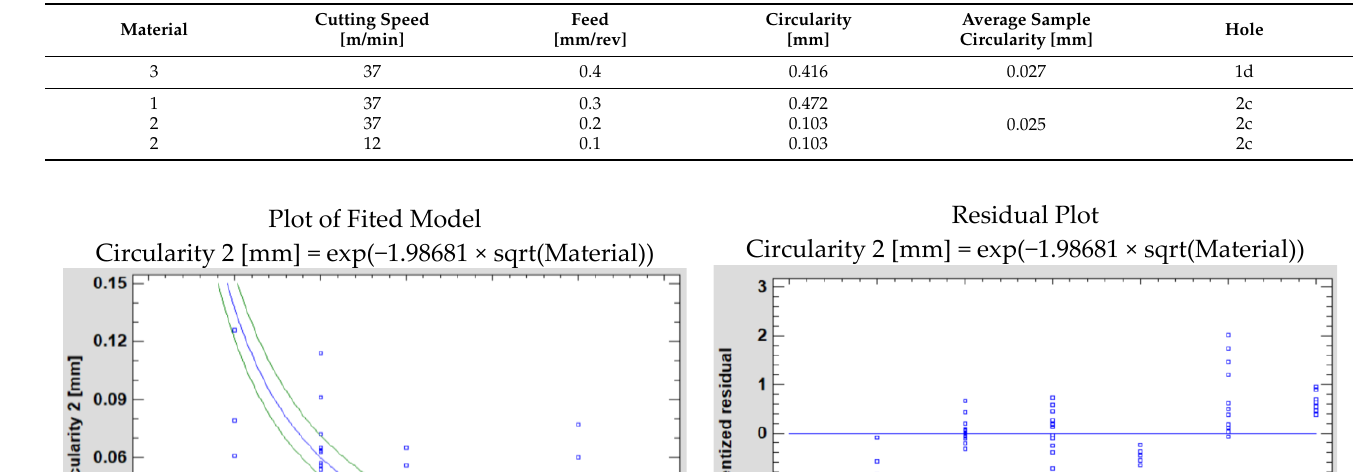
Figure 6. Comparative violin plot showing the measured values for the four holes on the sample’s P2 measurement plane’s deviation from circularity. Table 3. Holes with manufacturing errors.